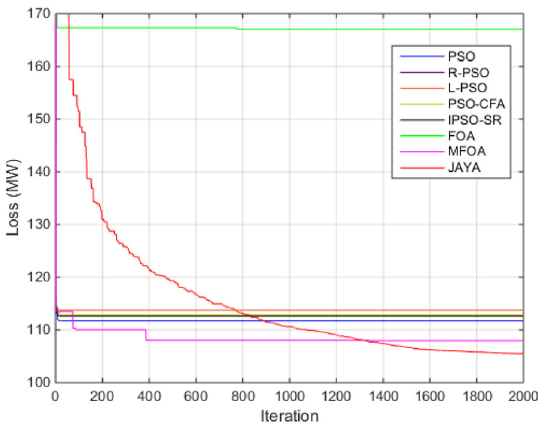
Fig. 5 Convergence characteristics of the algorithms for the IEEE 118 bus system without DG injection